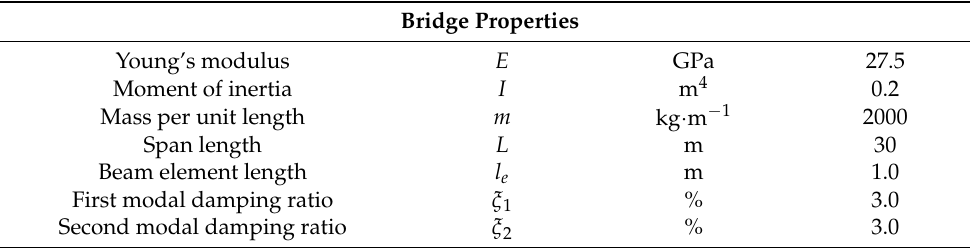
Table 2. Physical properties of